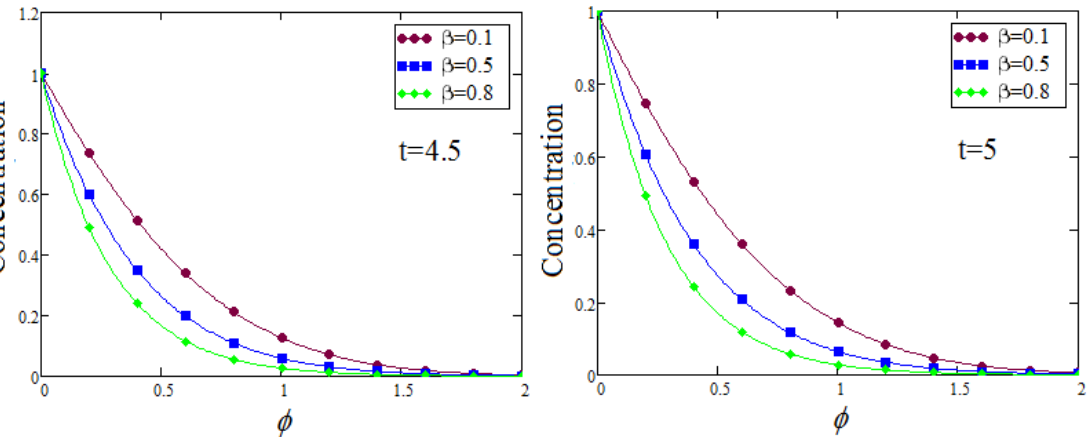
Figure 7. Graphical representations of concentration profile by taking distinct values of β at two different levels of time, when Sc = 9, ℘ = 0.4, α = 0.3, and γ =